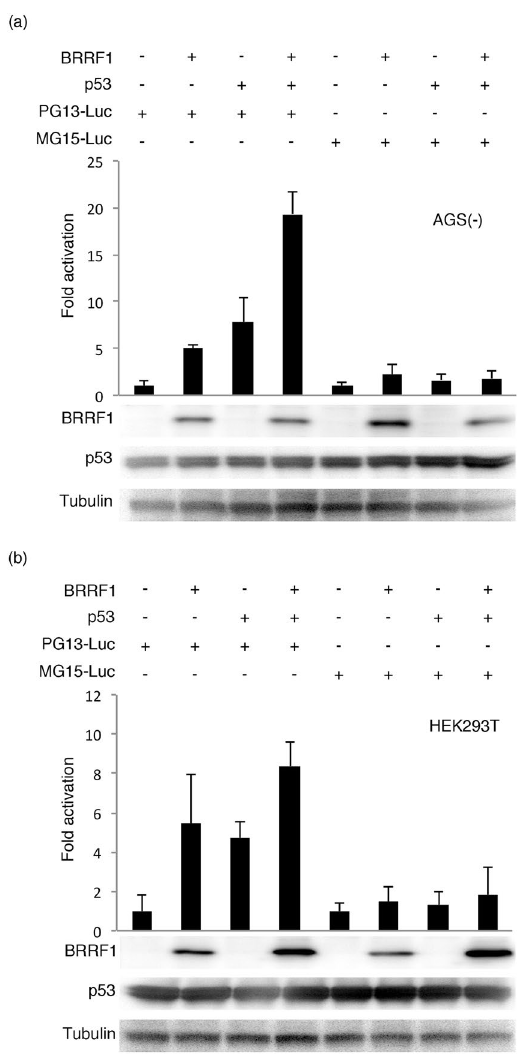
Figure 7. Evaluation of p53-dependent transcription activity. Expression vectors were transfected into AGS(-) ( a ) or HEK293T ( b ) cells along with PG13-Luc, containing 13 wild-type p53 response elements, or MG15-Luc, containing 15 mutated p53 response elements, and null-RL by lipofection. Cells were collected after 24 hours and subjected to luciferase assays. FL activity was normalized to RL, and the values for the cells transfected with the empty vector (pcDNA3) were set to 1. Cell lysates were subjected to immunoblotting, and a representative result is presented below the graph. The original blots are presented in Supplementary Figures 20 and